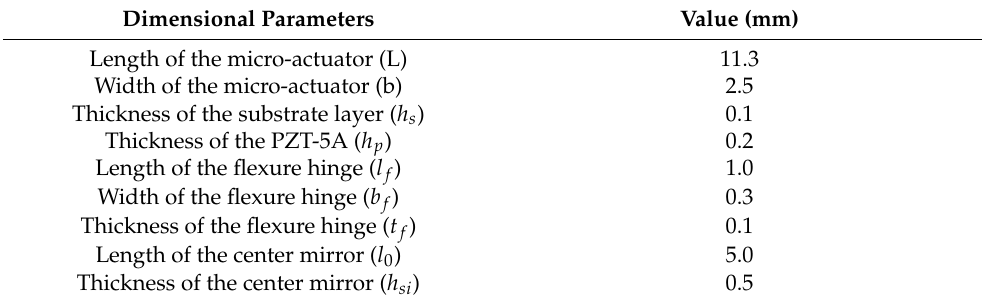
Table 2. Structural parameters of the piezoelectric nano-positioning stage.